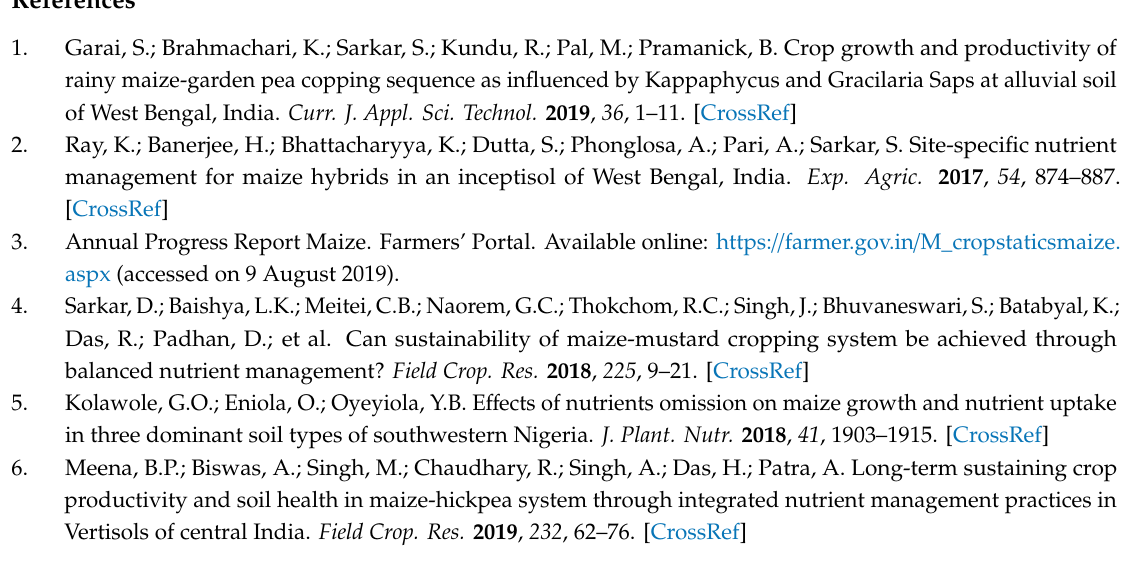
Supplementary Materials: The following are available online. Table S1. Nutrient content (%) in di ff erent organic manures, Table S2. Physico-chemical properties and nutrient status of post-harvest soil (after the first year of maize